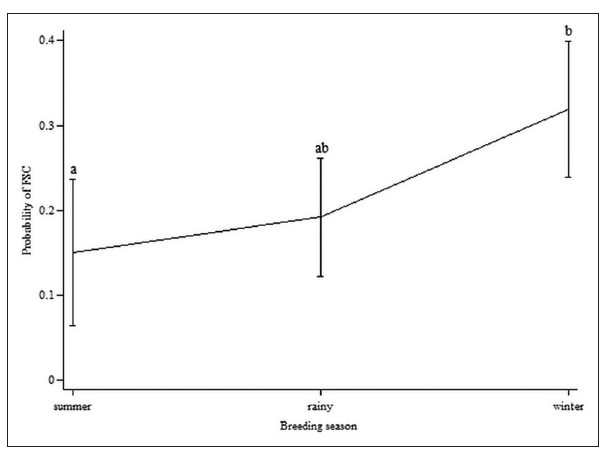
Figure-2: Probabilities of first service conception corresponding to breeding seasons among 295 cows on 43 smallholder farms in Thailand in